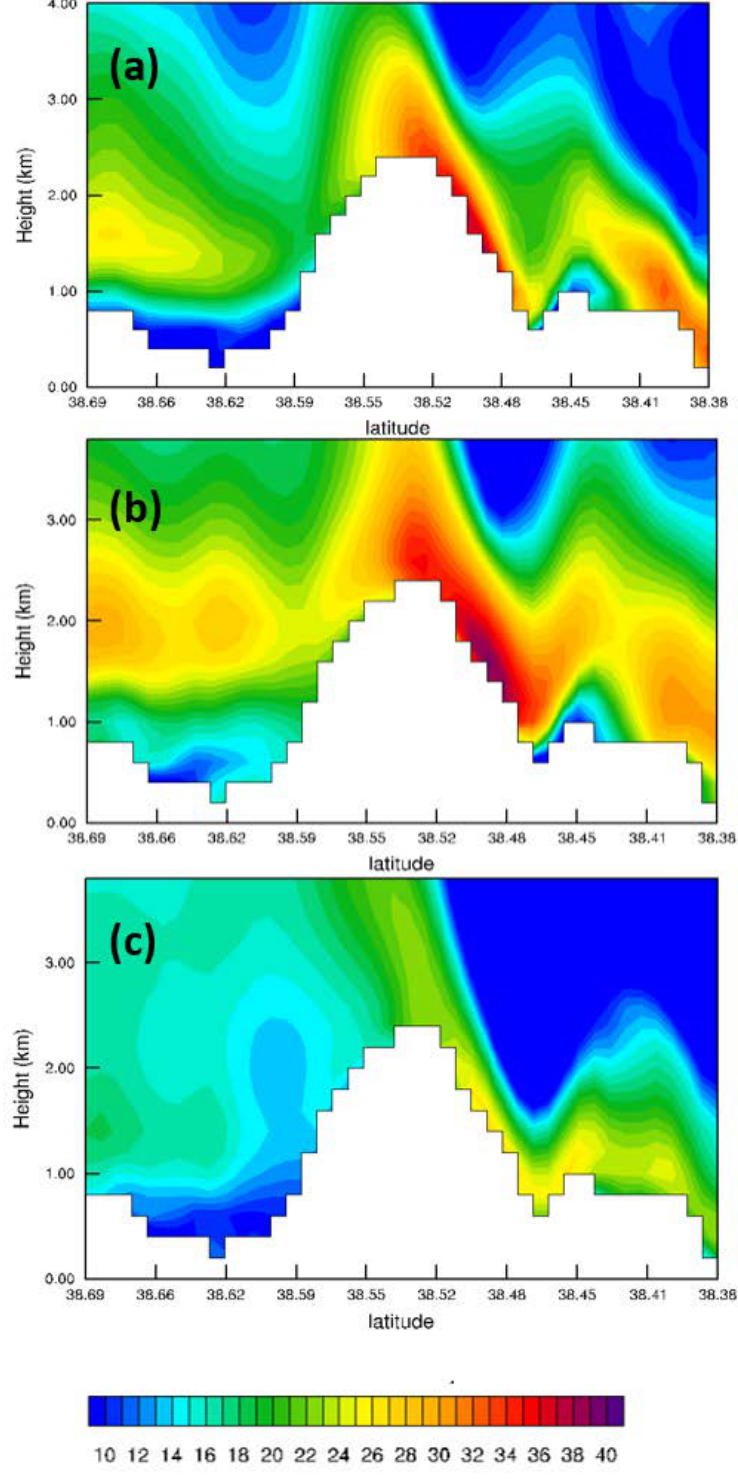
Figure 8. Horizontal wind speed (m s − 1 ) at the time of the maximum speed occurrence for each simulation: ( a ) 14 February 2019, 03:00 UTC; ( b ) 6 January 2020, 16:00 UTC; ( c ) 15 February 2021, 18:00 UTC.